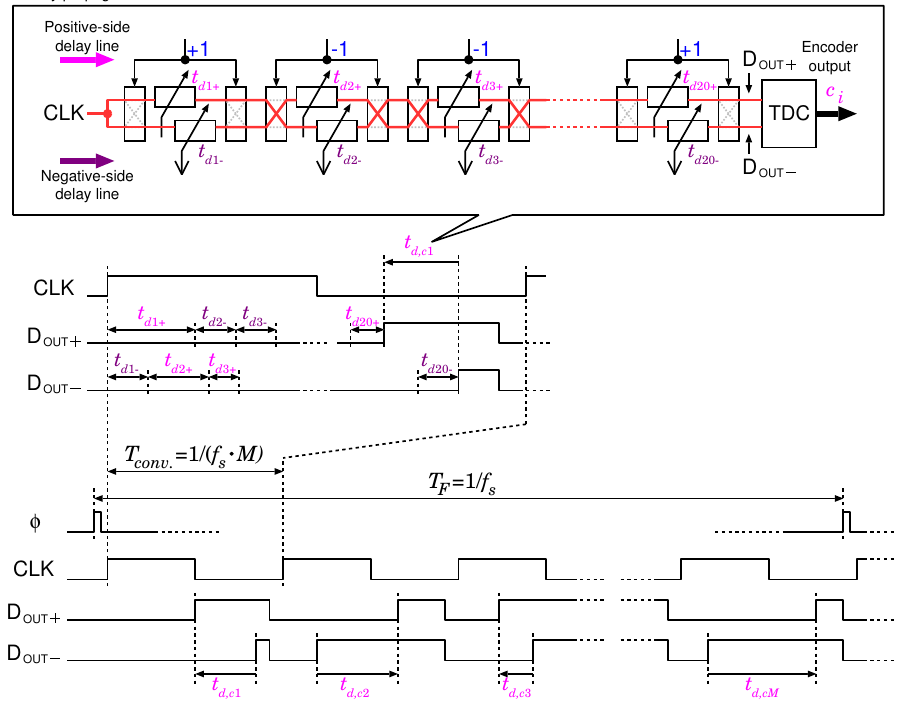
Figure 5. Timing diagram of the proposed CS